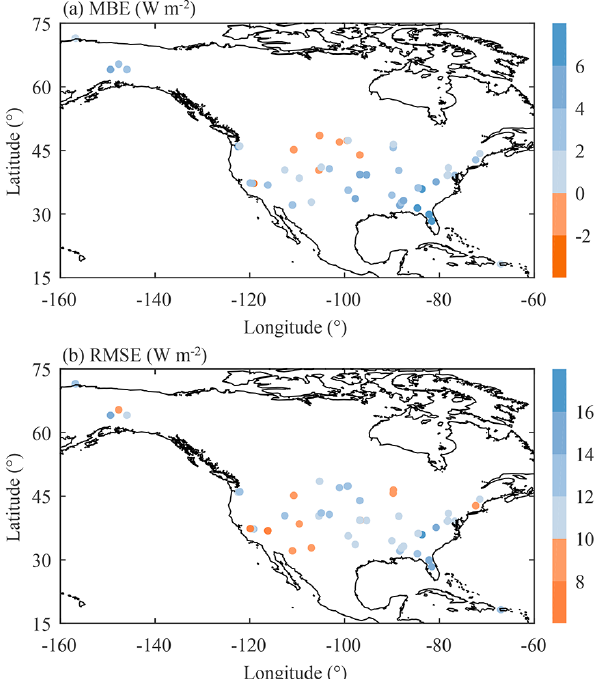
Figure 7. Same as Fig. 4, but for our estimated daily PAR product (ISCCP-ITP, 30km).